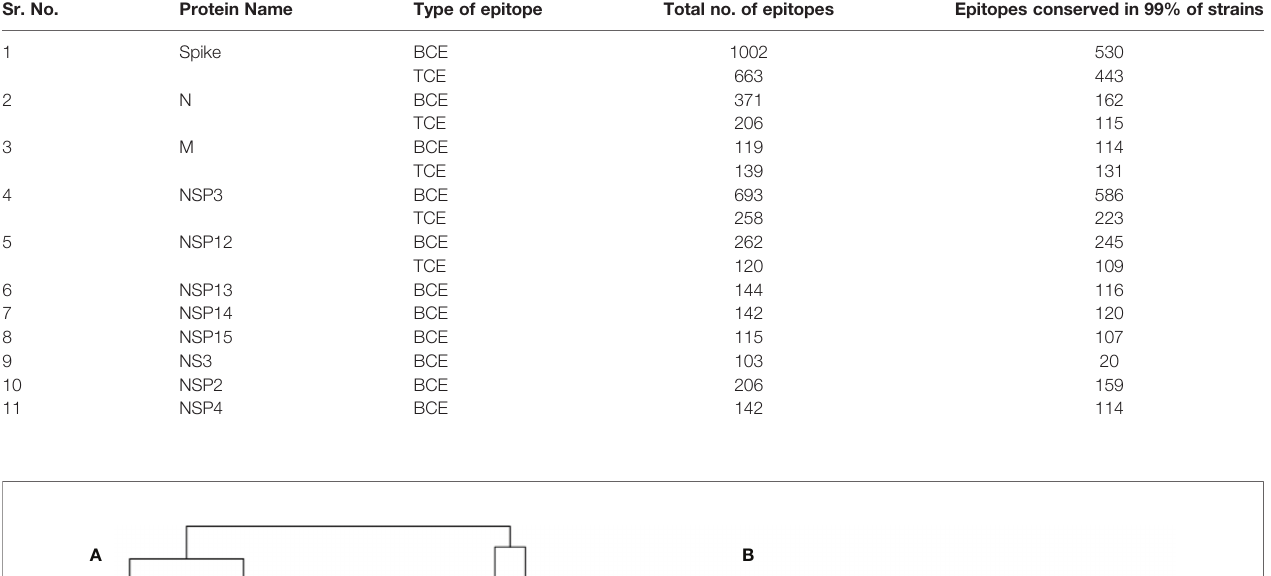
TABLE 1 | Highly conserved epitopes in different proteins from SARS-CoV-2. Sr. No.